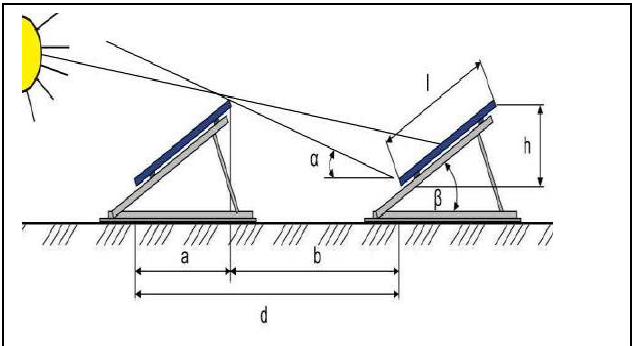
Fig. 3. PV inter row spacing exploration